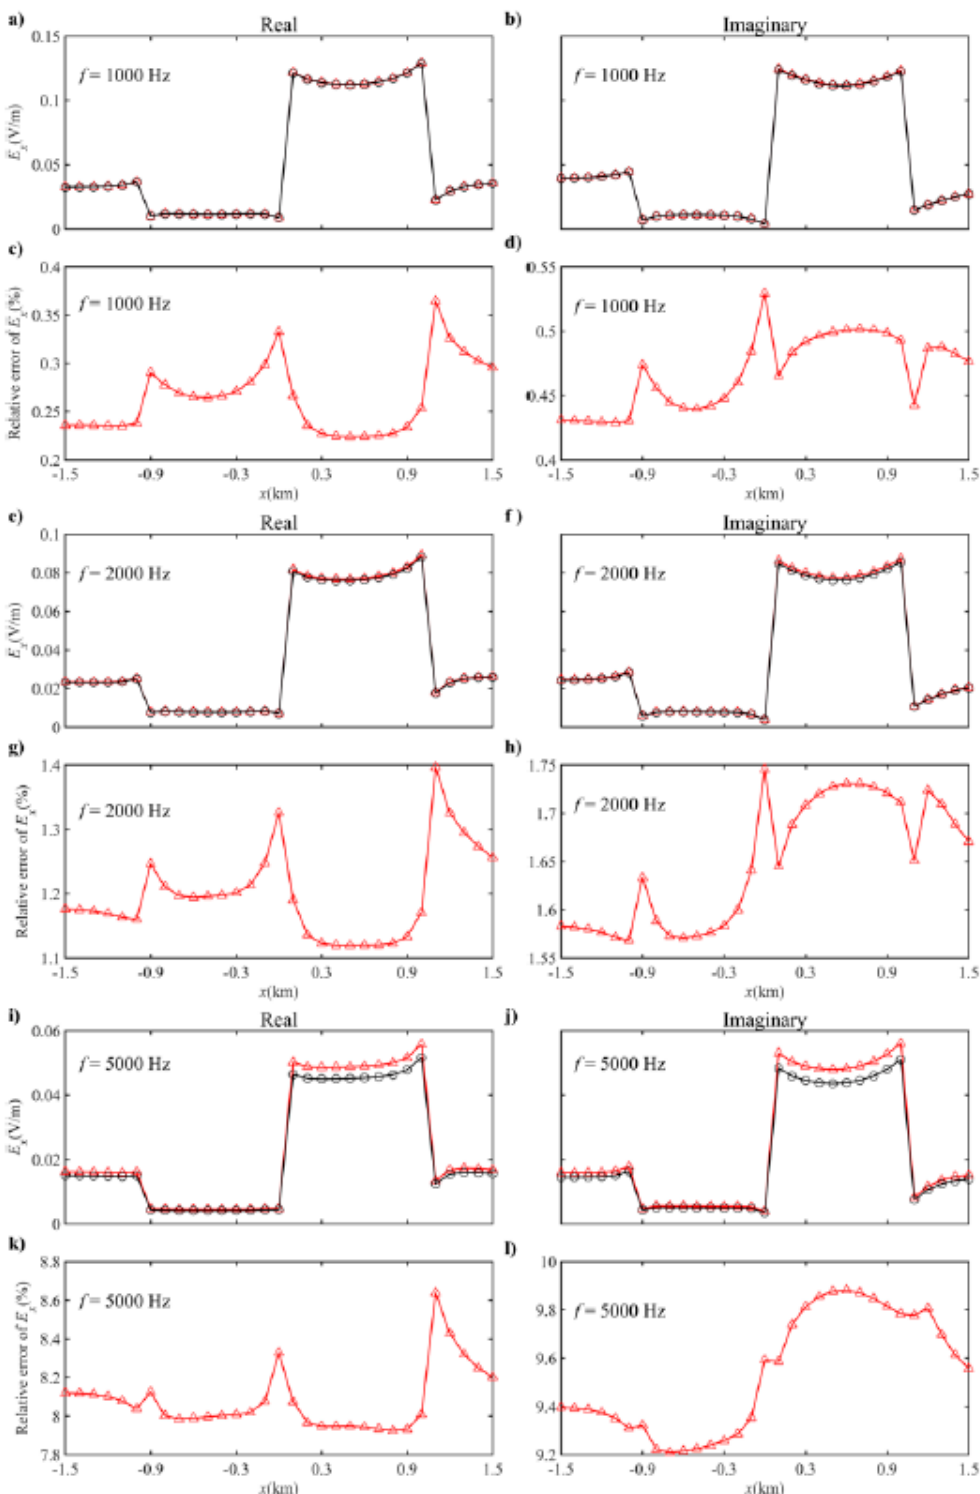
Figure 5. Comparison of the E x numerical solutions from the case based on the quasi-static approximation (upward-pointing triangle lines) with 10 − 8 S / m for air conductivity, and the one with the complete wavenumber (circle lines) at frequencies of ( a – d ) 10 3 , ( e – h ) 2 × 10 3 , and ( i – l ) 5 × 10 3 Hz for the 3D flat model. The relative errors are referenced to the results based on the use of the complete wavenumber.